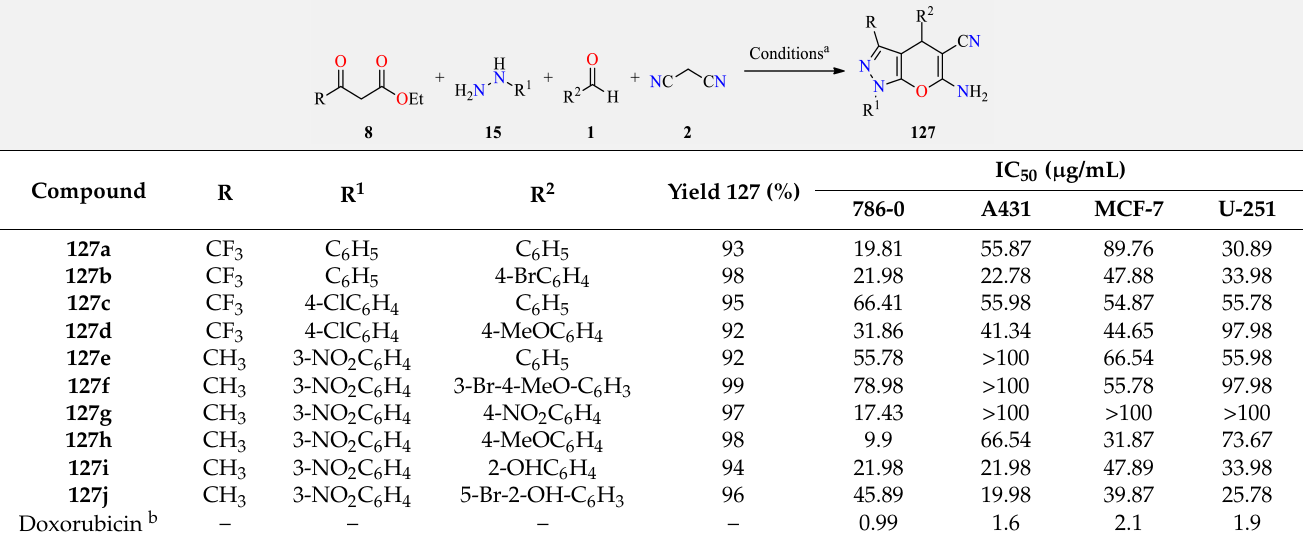
Table 34. Zn(OTf) 2 -catalyzed one-pot four-component synthesis of 6-amino-1,4-dihydropyrano[2,3- c ]pyrazole-5-carbonitriles 127 as anticancer